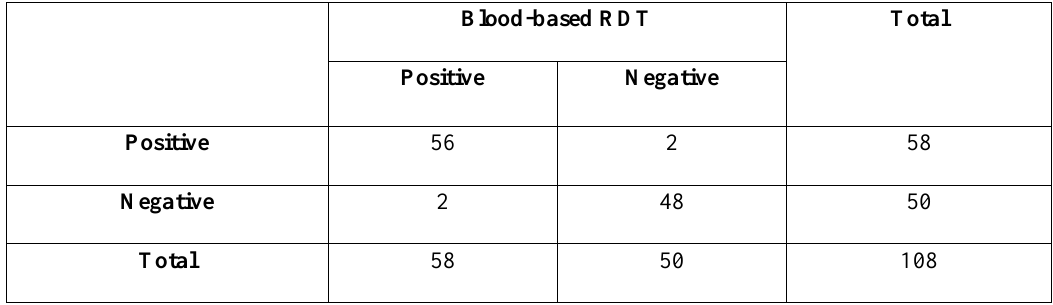
Table 2. Blood-based RDT results regarding blood smear microscopy for Plasmodium falciparum malaria (BFFPfM) as a reference method.